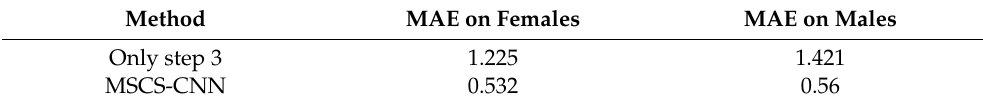
Table 4. Comparing bone age assessment performance with and without maturity stage classification. Method